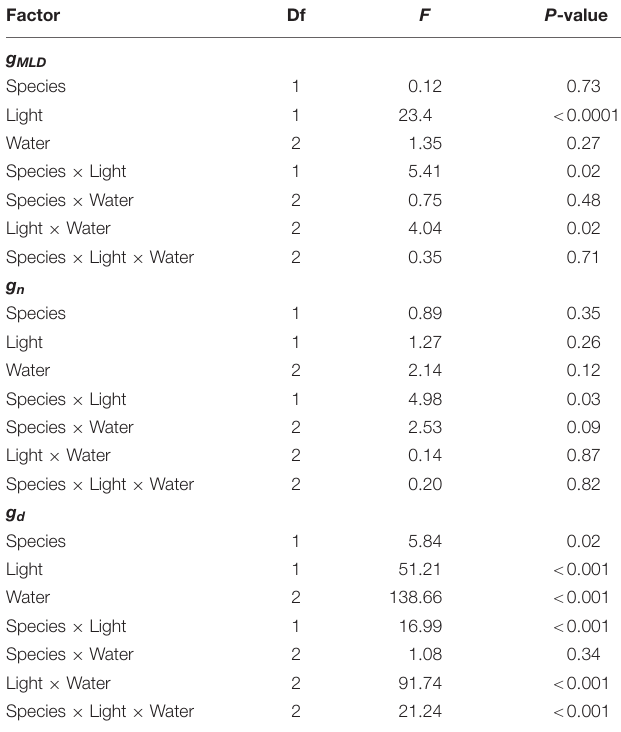
TABLE 1 | ANOVA Table on the effects of species, light treatment, water treatment on residual conductance measured from the mass loss of detached leaves ( g MLD ), from nocturnal conductance ( g n ), and also from daytime conductance ( g d